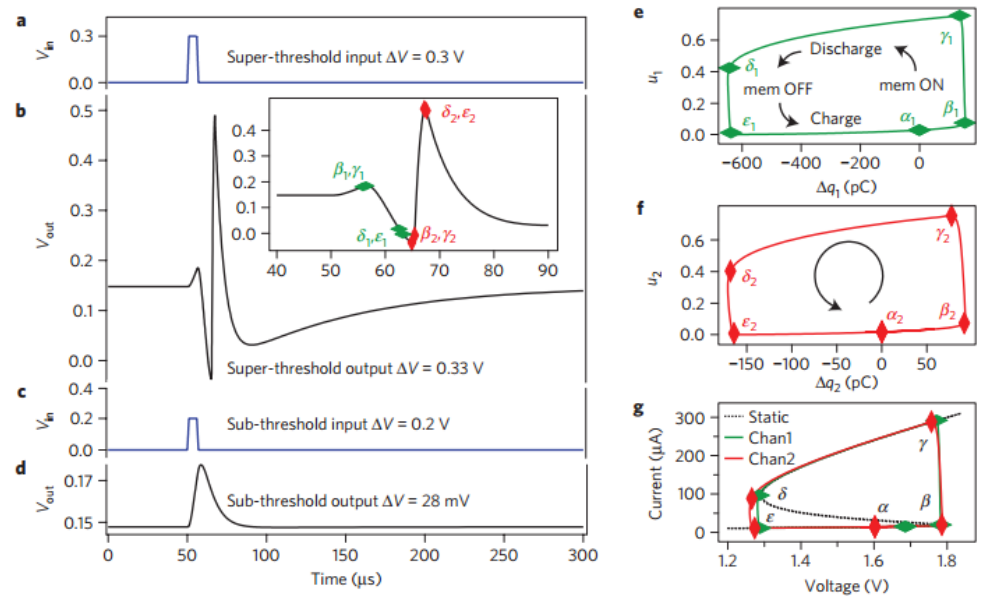
Figure 12: All-or-nothing response and state variable dynamics of the neuristor. (a), (b), Simulated super-threshold 0.3 V input pulse (a) and its corresponding spike output (b). The magnified spiking region (b, inset) highlights the time sequence of events for channels one and two. (c),(d), A sub-threshold 0.2 V input (c) to the same device yields an attenuated output (d). (e),(f), Phase portraits of the characteristic state variables u and q for channel 1 (e) and channel 2 (f) illustrate a stable trajectory for both channels during the spike activation period of (b). Points labelled α to ϵ on the phase portraits indicate the special points associated with switching events in each channel. (g), Trajectories around the quasi-static current–voltage curve illustrate the conductive state of the respective Mott memristor for each channel at each point of interest. (Reprinted with permission from M-D Pickett, G. Medeiros-Ribeiro, R.S. Williams// Nature Materials 12 (2012)114 (C) 2012 Nature publishing